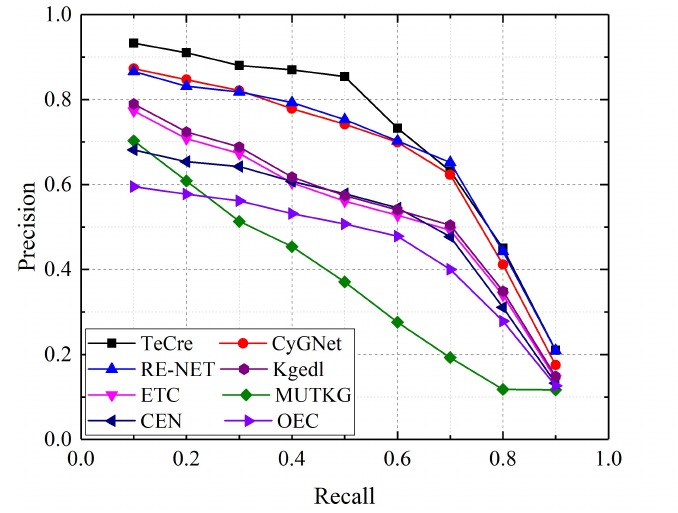
Figure 4. Comparison results on the ICEWS’14